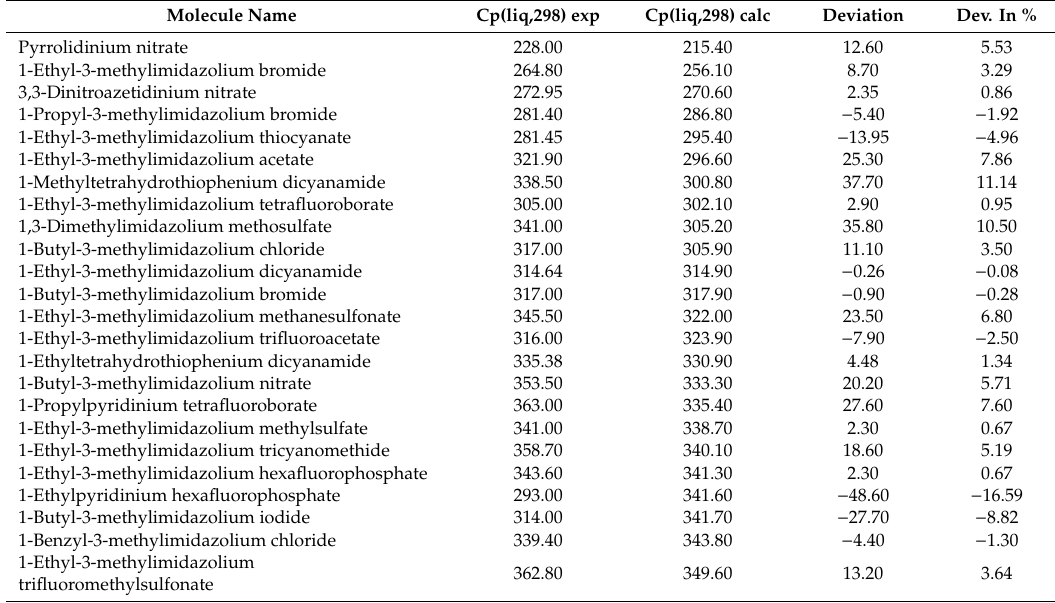
Table 3. Experimental and Equation (2)-calculated Cp(liq.298) of 145 OH-free ionic liquids in J/mol/K.